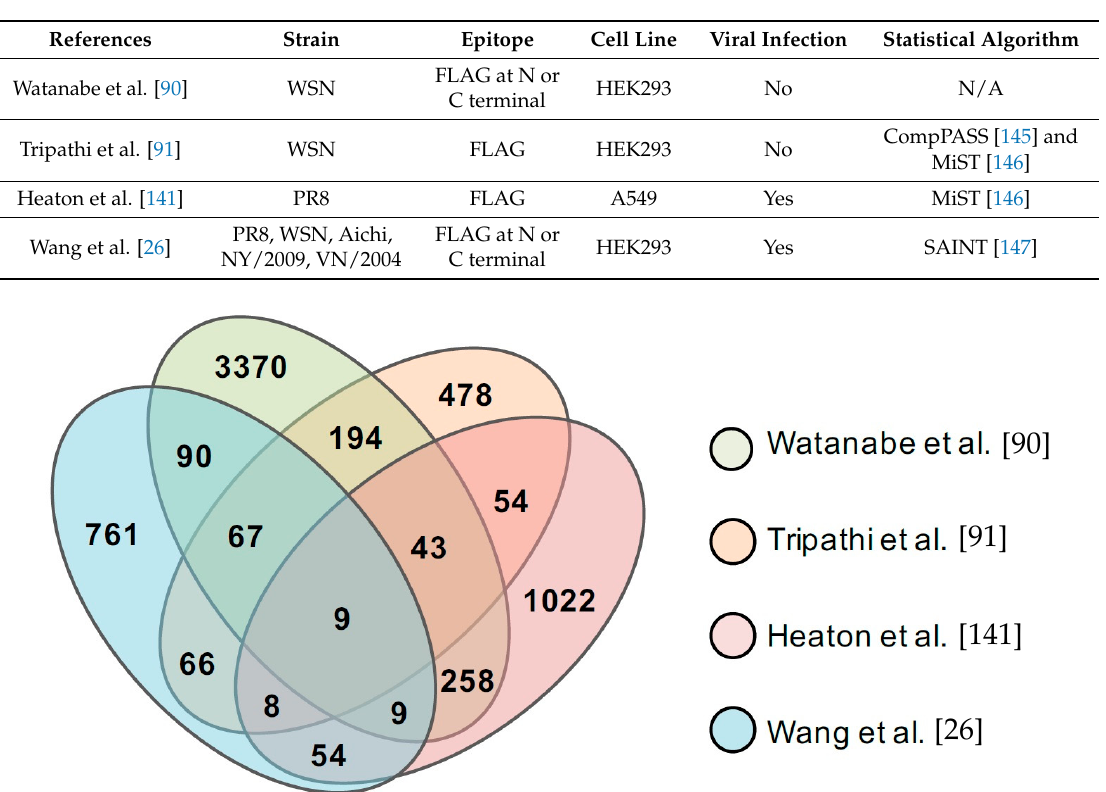
Figure 1. Venn diagrams illustrating the number of common host factors identified in different studies.